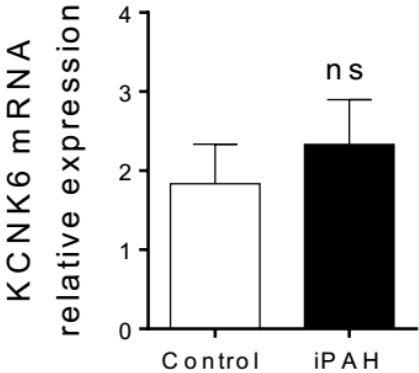
Figure 12. mRNA expression of KCNK6. Unchanged expression of KCNK6 mRNA in isolated pulmonary arteries from control ( n = 5) and iPAH patients ( n = 5). Gene expression was quantified using qPCR following the standard protocol for ready-to-use TaqMan gene expression assays (Life Technologies) on a StepOne Plus Real-Time PCR System (Life Technologies). KCNK6 mRNA expression was normalized by β-Actin mRNA (Hs00559239_g1 and Hs01060665_g1).